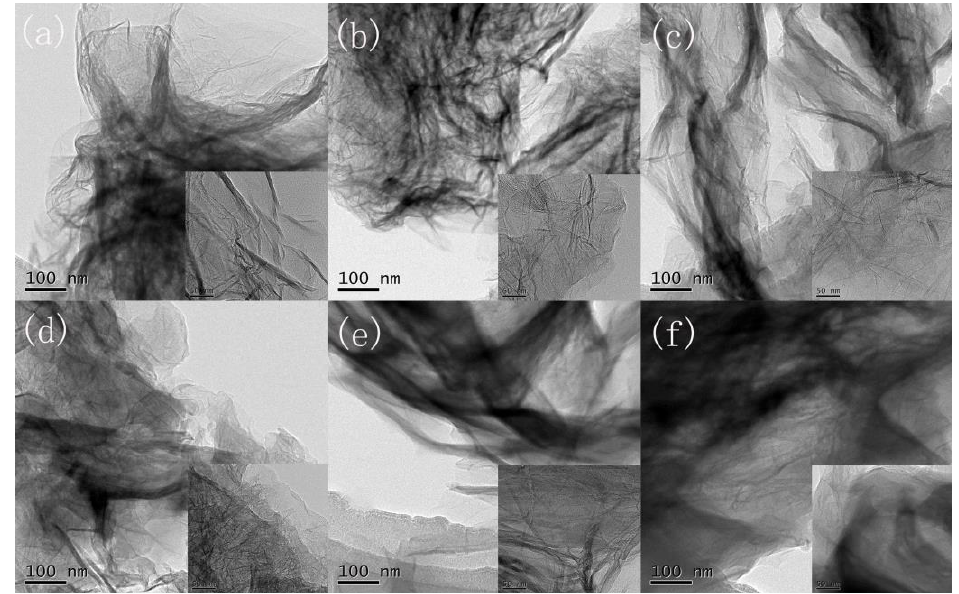
Figure 5. TEM images of rGO ( a ), GESA1 ( b ), GESA2 ( c ), GESA3 ( d ), GESA4 ( e ), and GESA5 ( f ) composites.